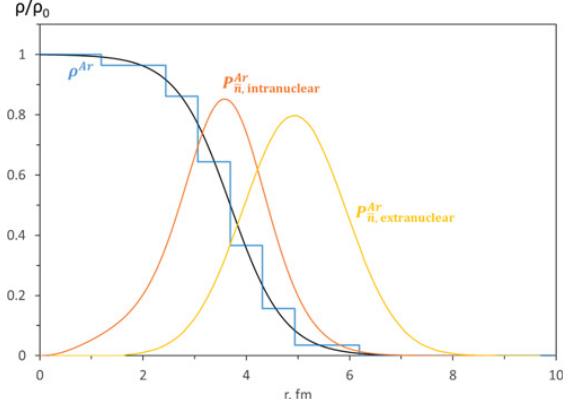
Figure 4. Using arbitrary normalizations for radial comparison purposes only, this plot shows 40 Ar ’s nuclear density distribution 18 in black (approximated by the blue stepped histogram), the approximate radial annihilation probability distribution of extranuclear annihilation on 40 Ar in yellow (assuming similarity 18 with [32]), and the same for an intranuclear annihilation in orange [33]. These distribution are shown as used in our group’s internal intranuclear n → ¯ n MC simulations, and represent extensions of our current work for the ESS NNBar collaboration in modeling of the free (extranuclear) transformation and subsequent annihilation on carbon [31,33]. Most pertinent to DUNE, the figure effectively shows differences between the current assumptions of [27], wherein the transformation and subsequent annihilation are supposed to occur along the density profile of the nucleus, and our modeling of the intranuclear annihilation position [30,32,33]. Though the effects and differences of these distributions are not yet entirely modeled or understood, it seems probable that such a distribution, when coupled with the low momentum dynamics of the nucleons near the surface of the nucleus, could lead to nontrivial aspherical event